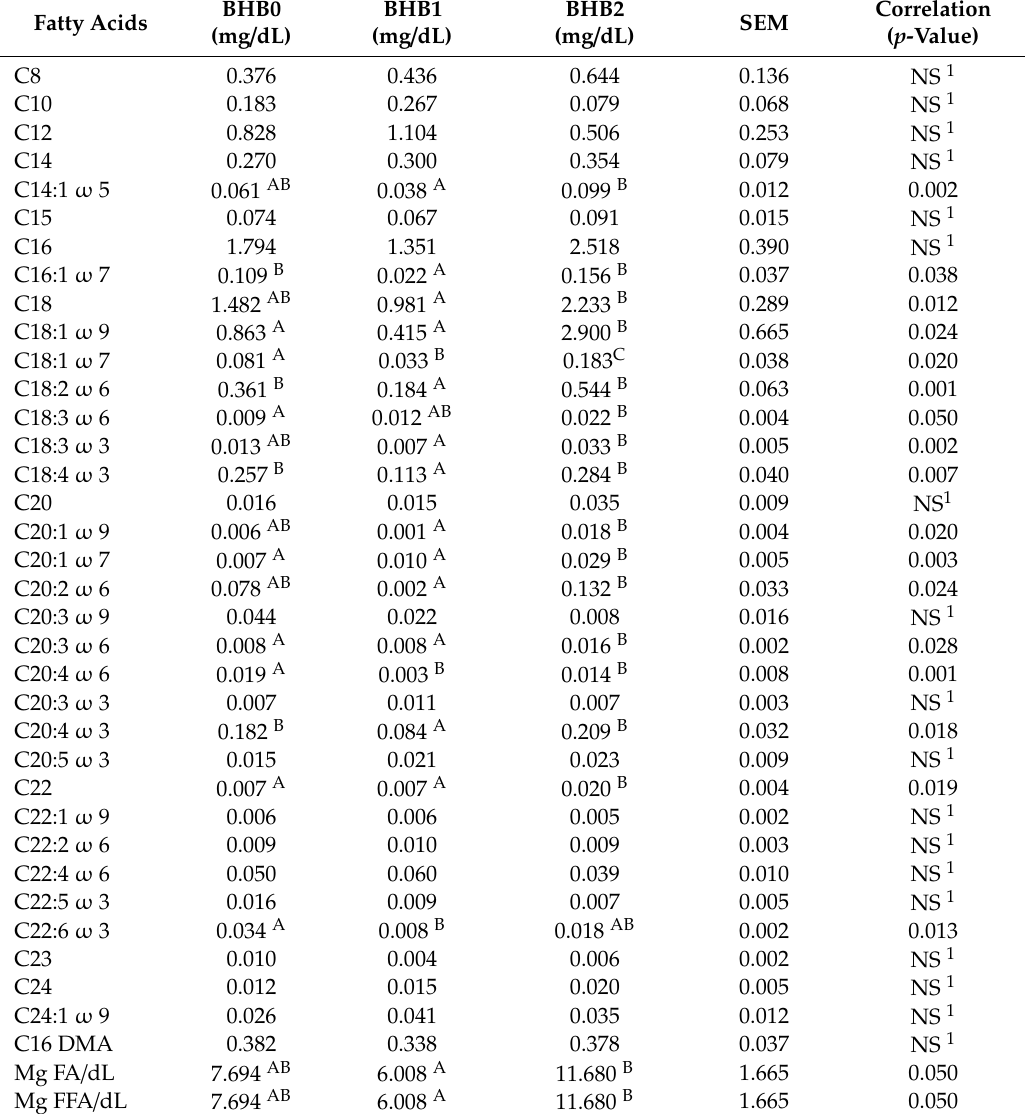
Table 4. Plasma fatty acid mean ( ± SEM) related to the lipid class of Free Fatty Acids (TLC-GC). Fatty